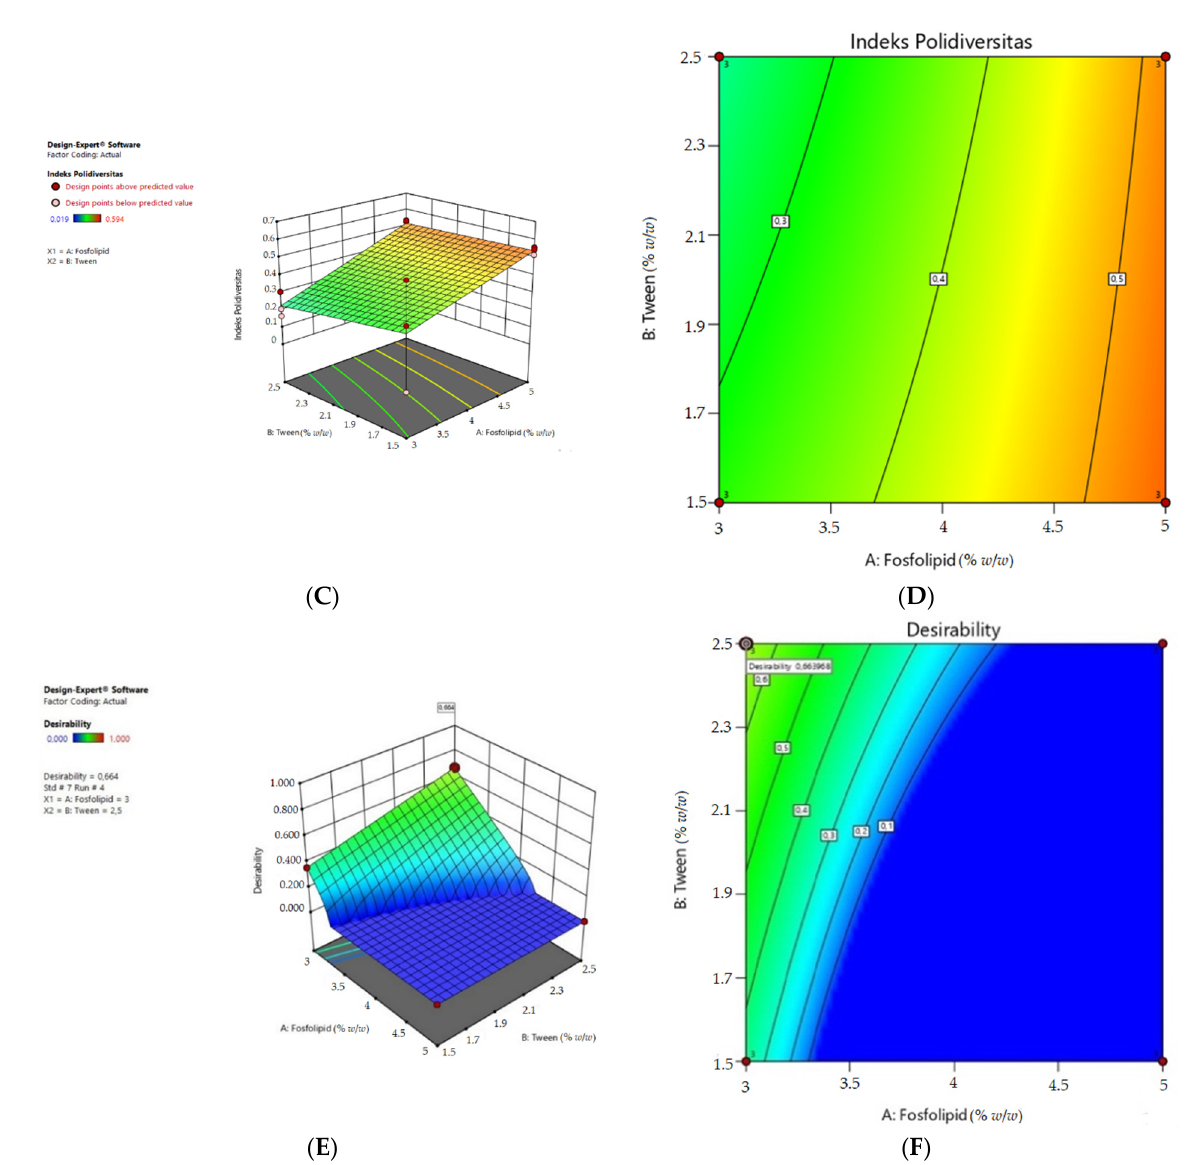
Figure 2. ( A ) 3D graphics of particle size response, ( B ) contour plot of particle size response, ( C ) 3D graphics of polydispersity index, ( D ) contour plot of polydispersity index, ( E ) 3D graphics of desirability, ( F ) contour plot of desirability.